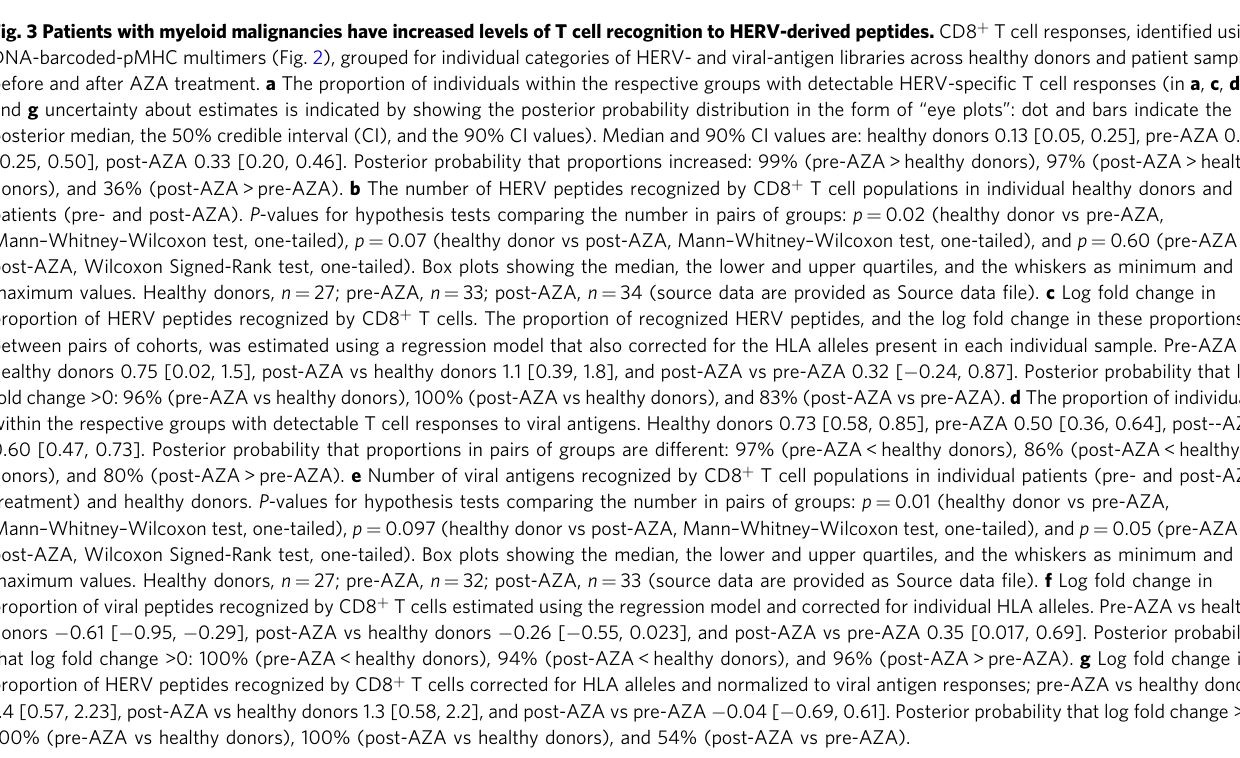
DNA-barcoded-pMHC multimers (Fig. 2), grouped for individual categories of HERV- and viral-antigen libraries across healthy donors and patient